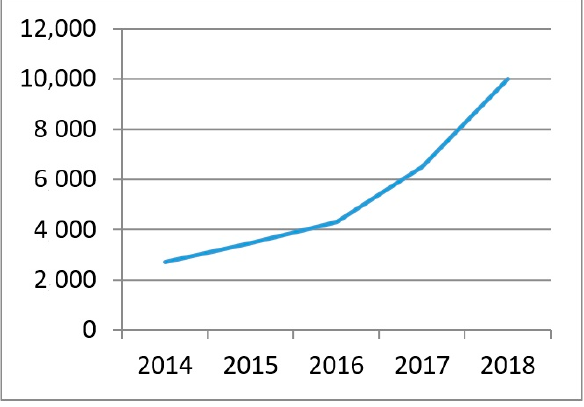
Figure 5. Evolution of Uber and Cabify drivers in Spain. Source: [26].